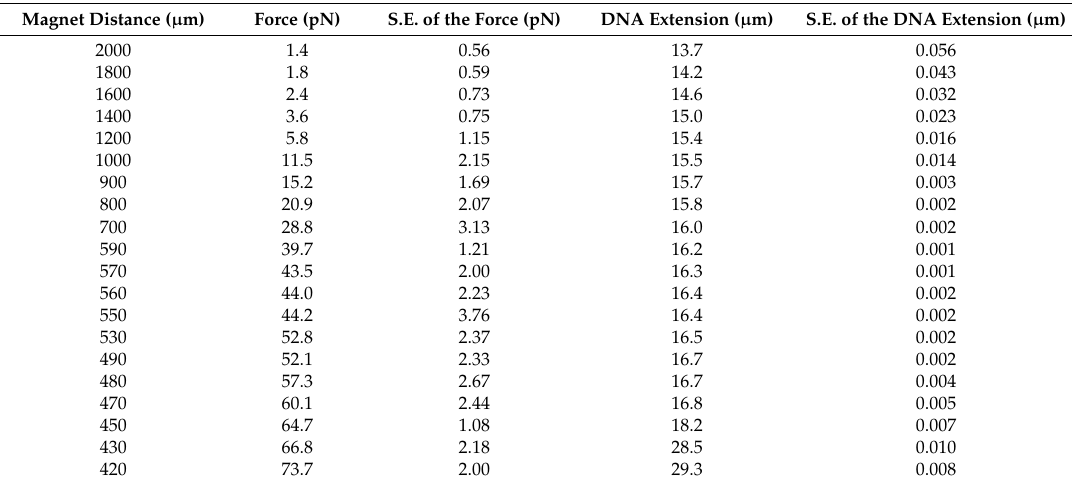
Table 1. The values of the force, DNA extension and their corresponding standard error (S.E.) of the tethered DNA at certain distance from the magnet.